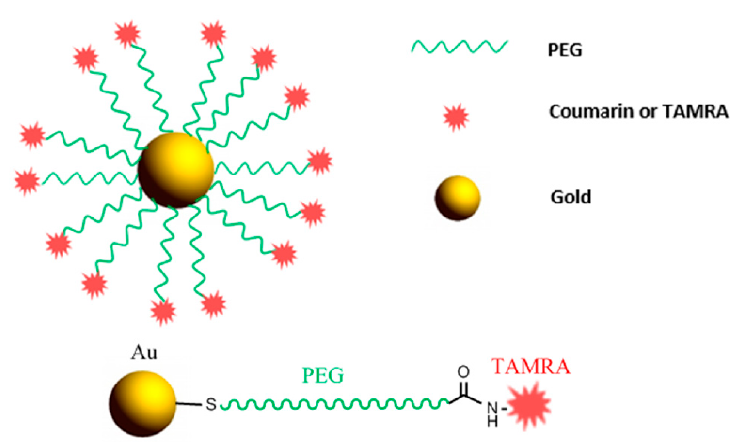
Figure 8. Targeted nanoparticle presented in Subsections 3.1 and 3.2 and chemical connectivity of TAMRA-PEG-Au nanoparticle design..